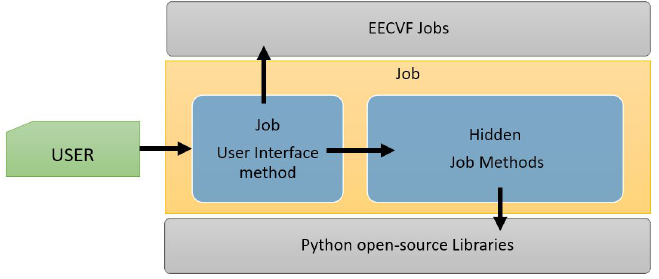
Figure 5. Job structure